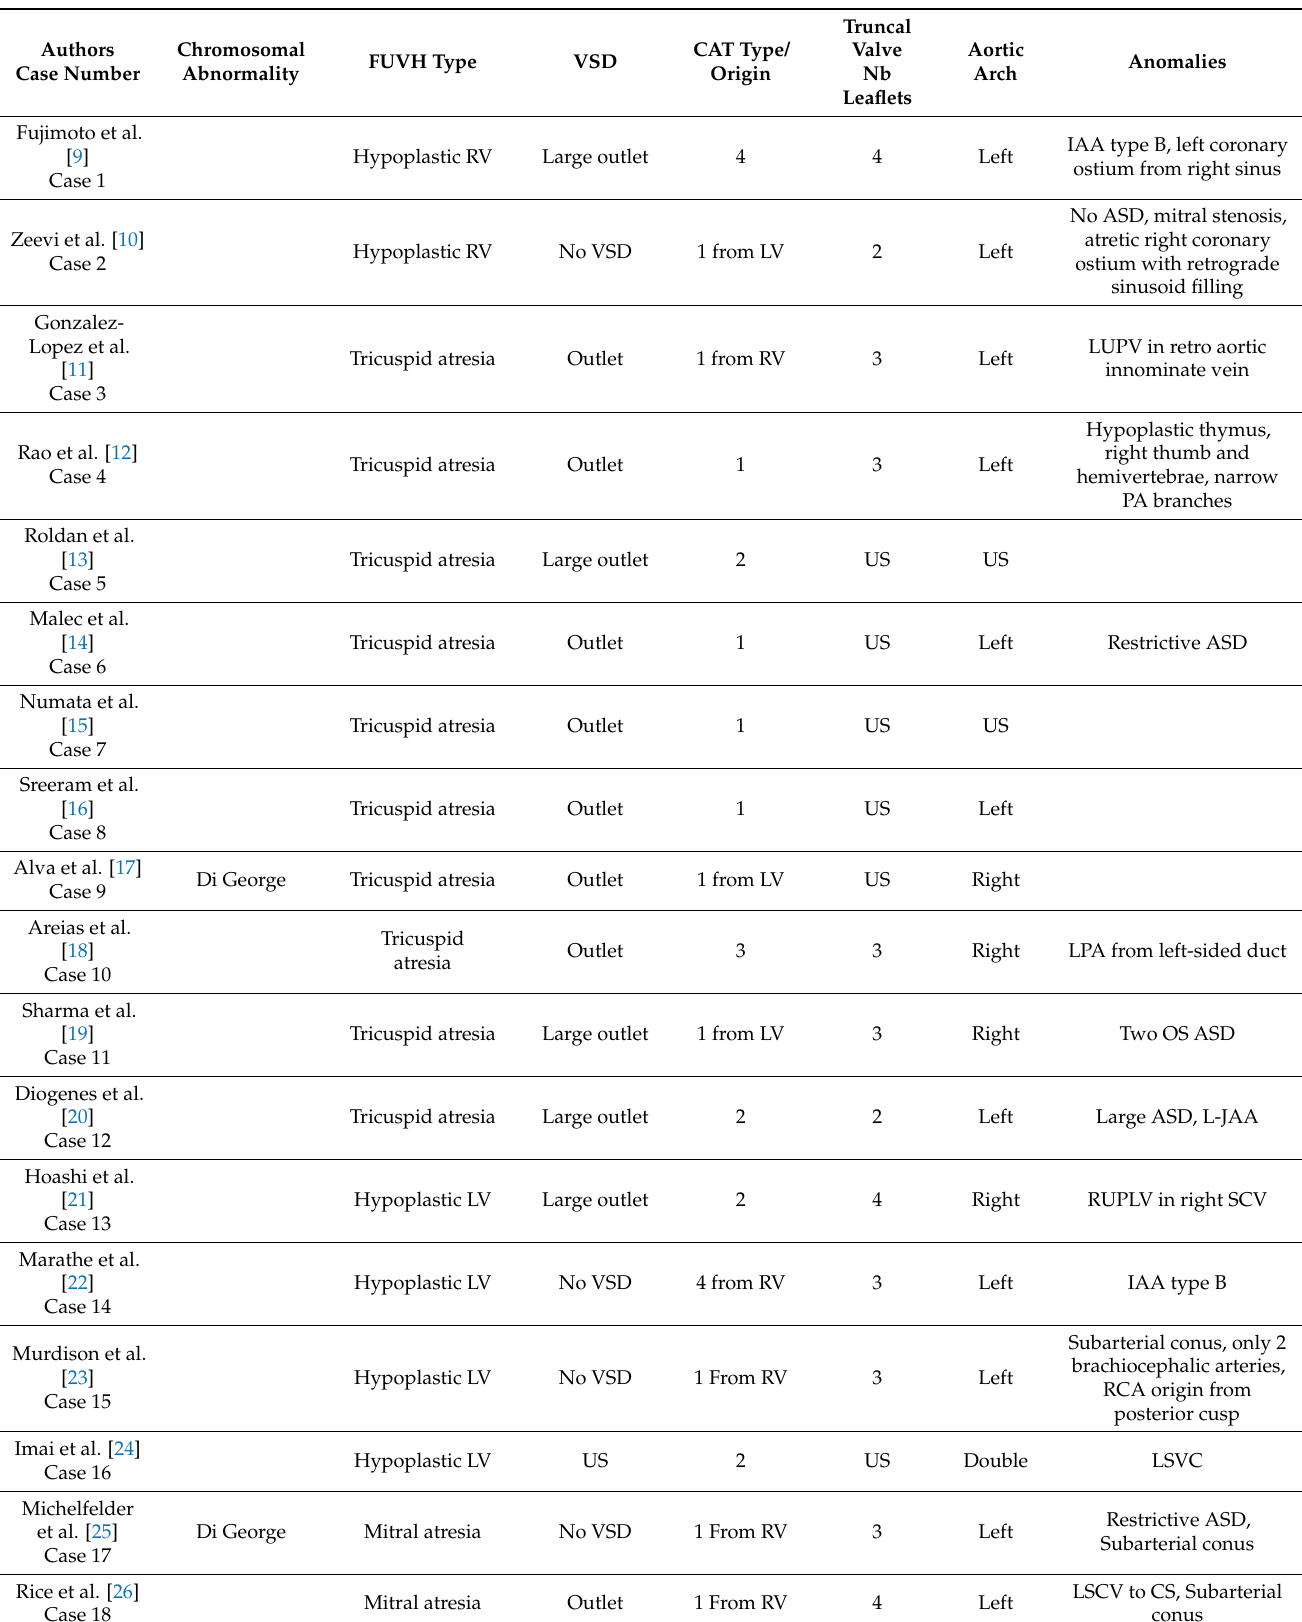
Table 1. Anatomical characteristics of cases 1 to